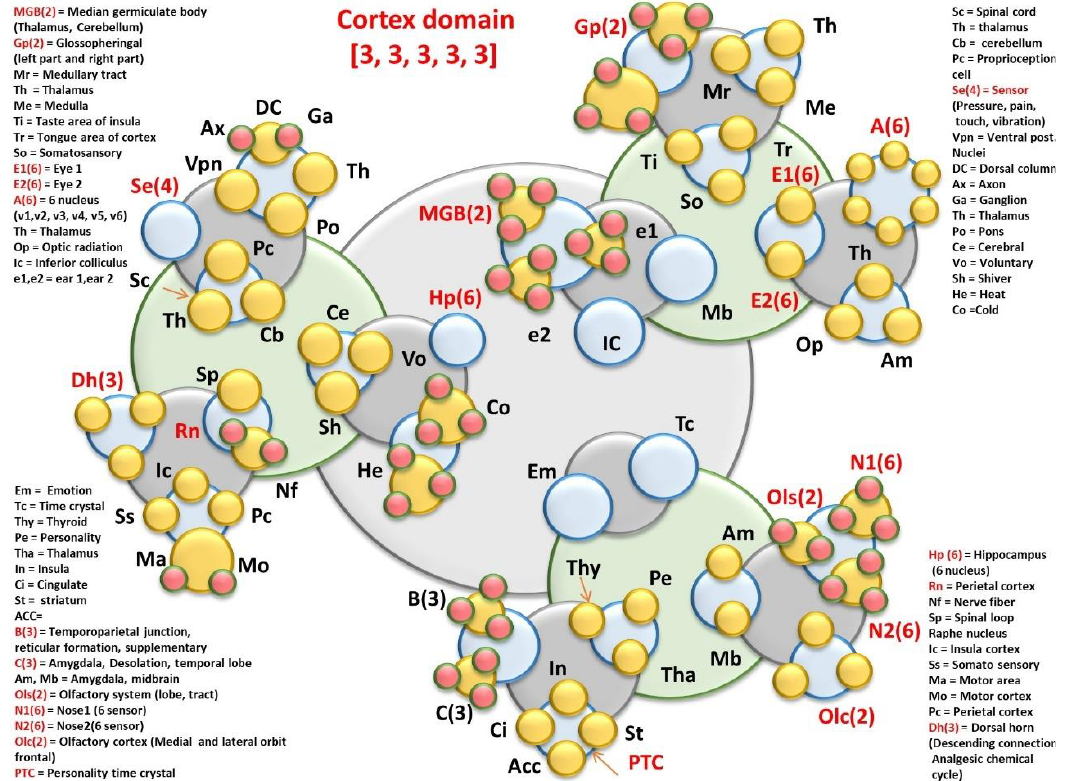
Figure 7. 2D clock architecture or time crystal representation of the cortical branch network of the brain [41].